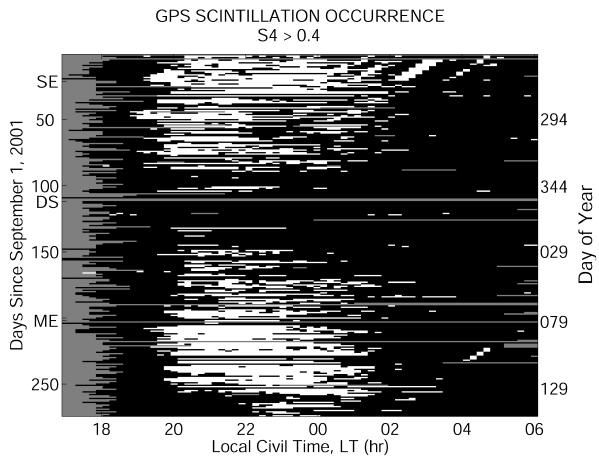
Table 2. Monthly occurrence frequency.